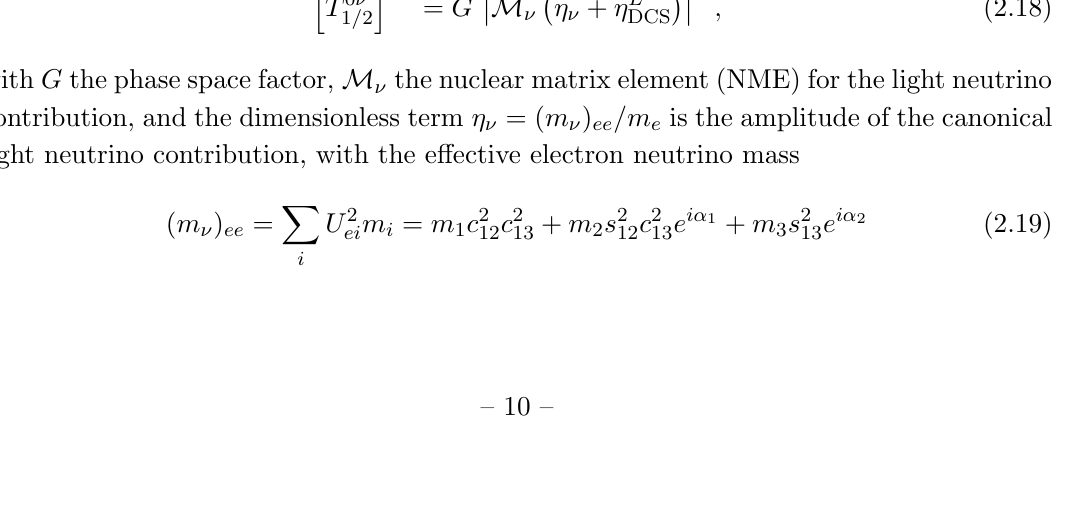
and the largest Yukawa H (cid:6)(cid:6) L p 4 (cid:25)